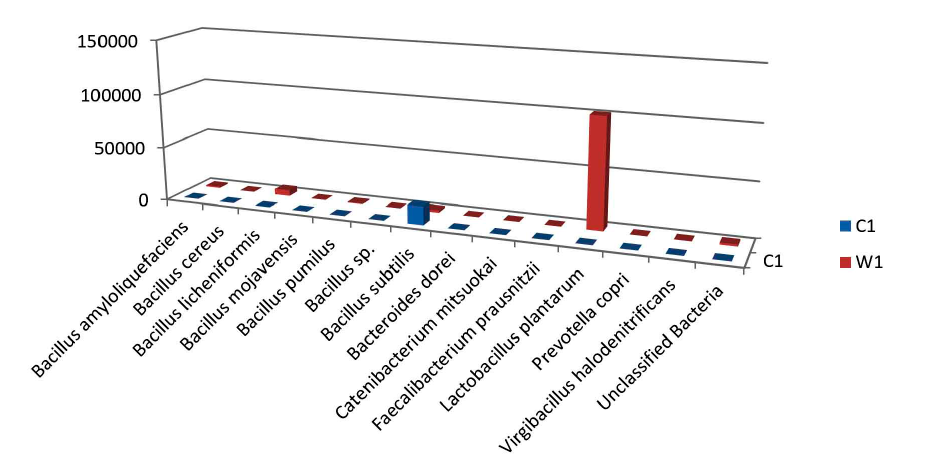
Fig. 3. Bar plot of Species level